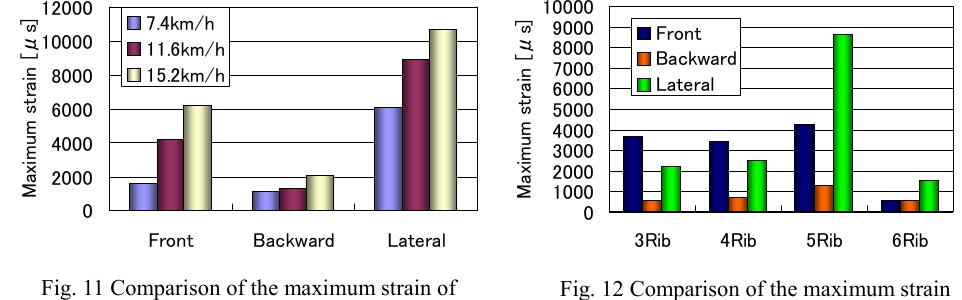
Fig. 12 Comparison of the maximum strain of the 3rd, 4th, 5th, and 6th rib at 11.6 [km/h] from each impact